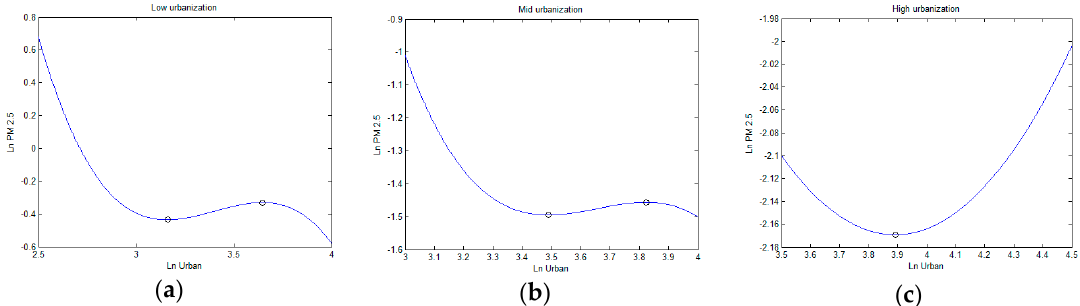
Figure 5. Diagrams relationship between population urbanization and PM 2.5 at different urbanization levels: ( a ) low urbanization level, ( b ) medium urbanization level, ( c ) high urbanization Table 6. Number of cities located in different population urbanization levels.